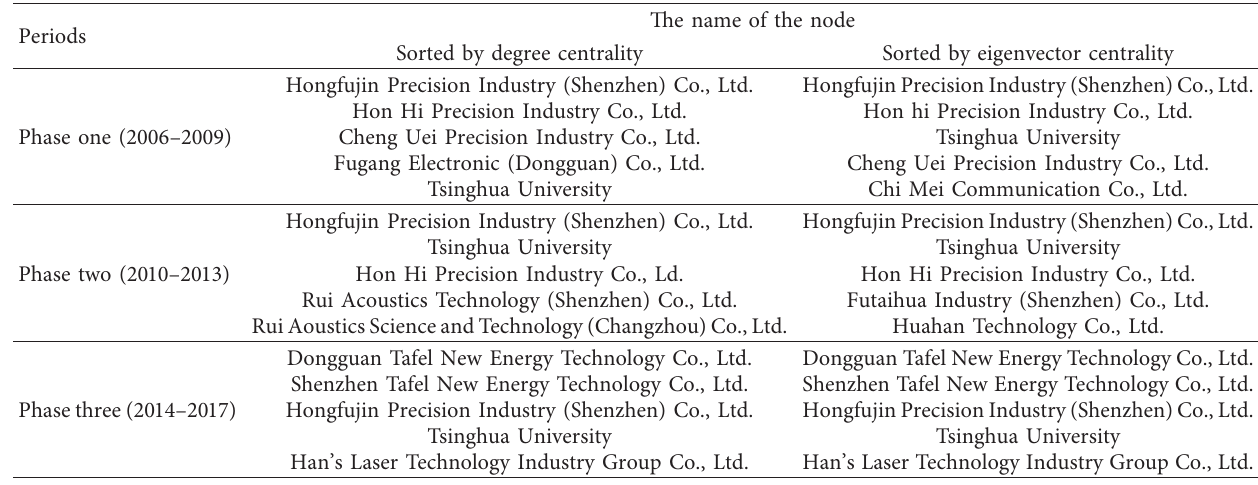
Table 2: Key nodes of the NEVs coinvention network.